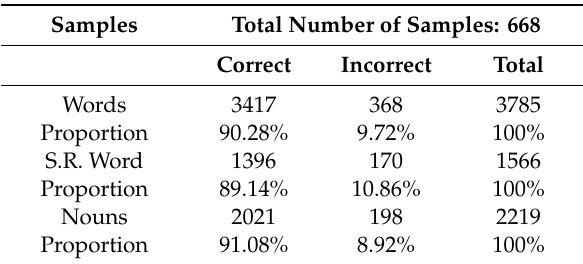
Table 5. Reliability analysis for generated